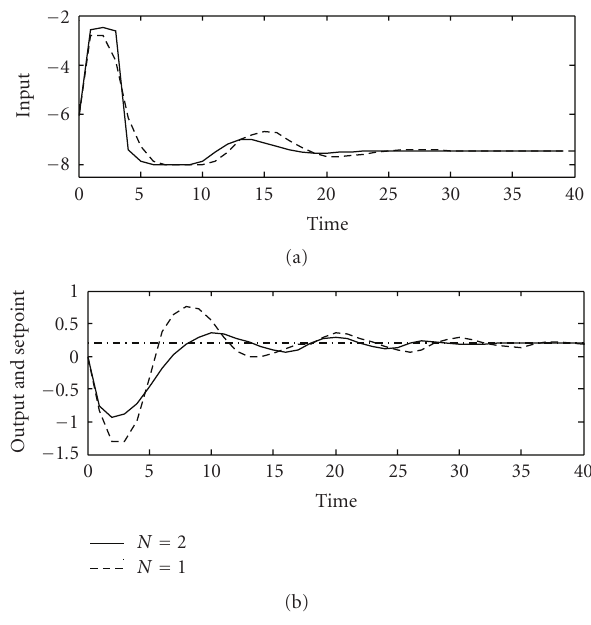
Figure 2: Tracking RMPC with N = 1 and N =